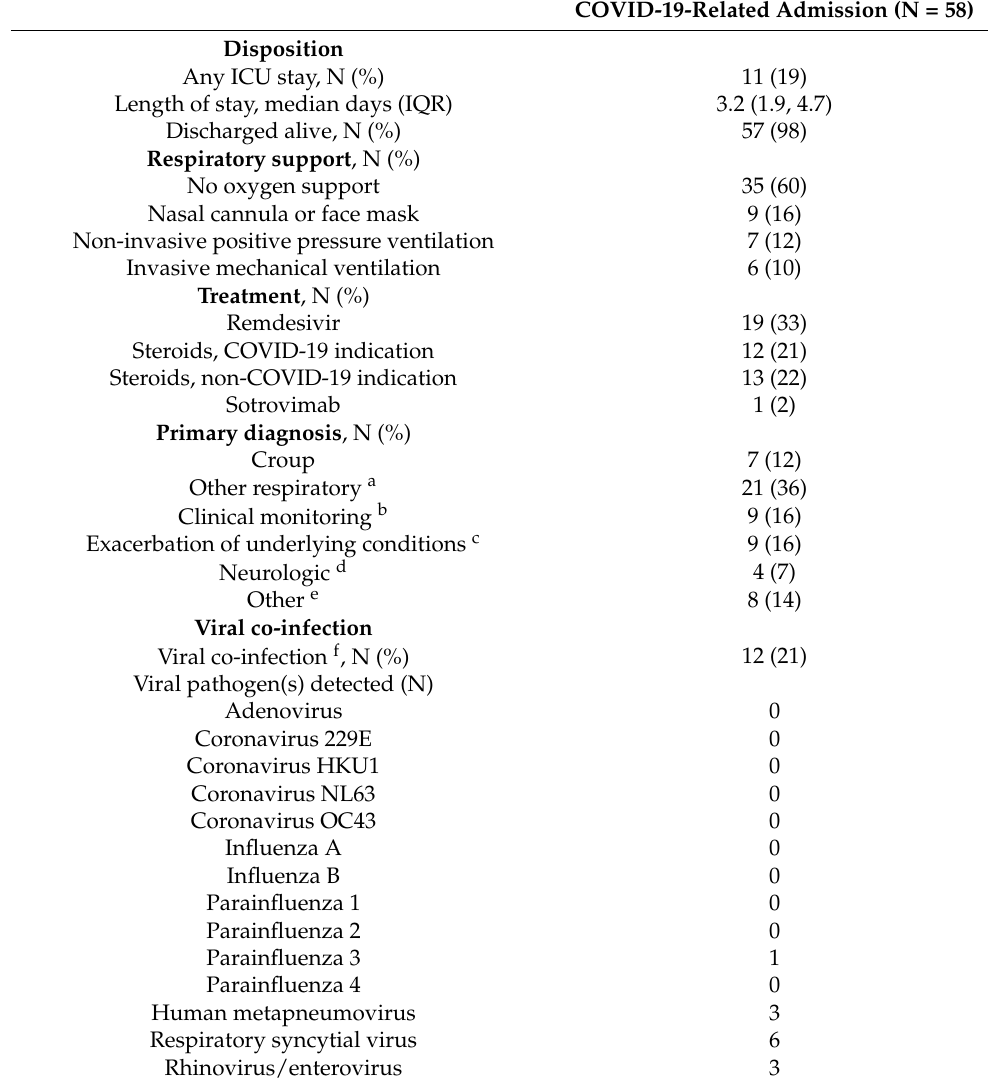
Table 2. Clinical Characteristics of Patients Aged ≤ 18 years Hospitalized for COVID-19-related Indication, 2 December 2021–23 January